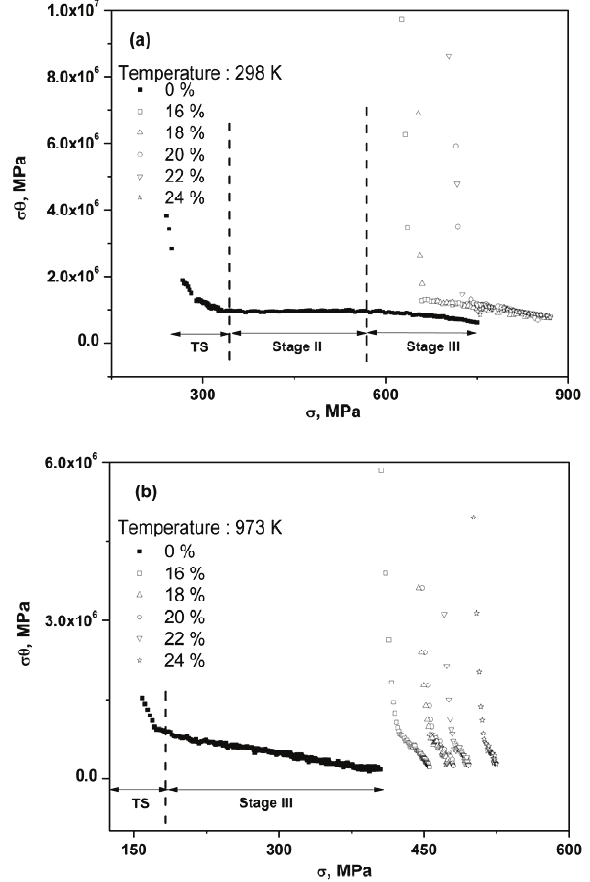
Figure 9. Effect of PCW on (cid:2)(cid:3) - (cid:3) plot at (a) 298 K and (b) 973